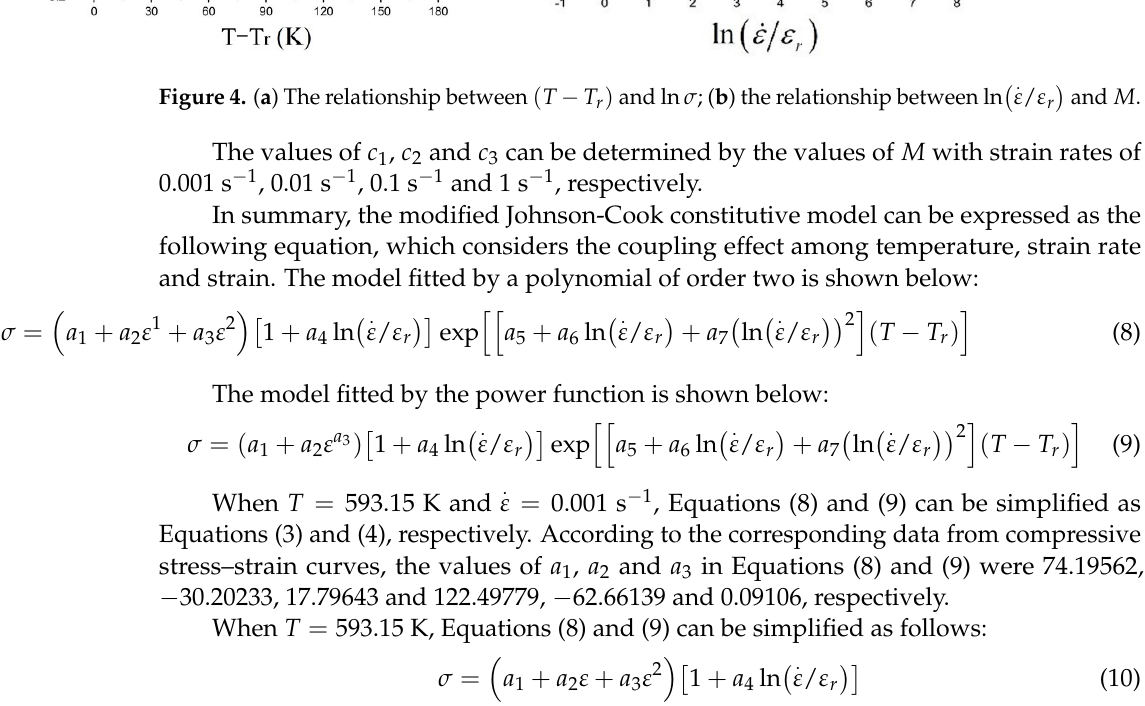
a a a , 2 and 3 in Equations (8) and (9) were 74.19562,